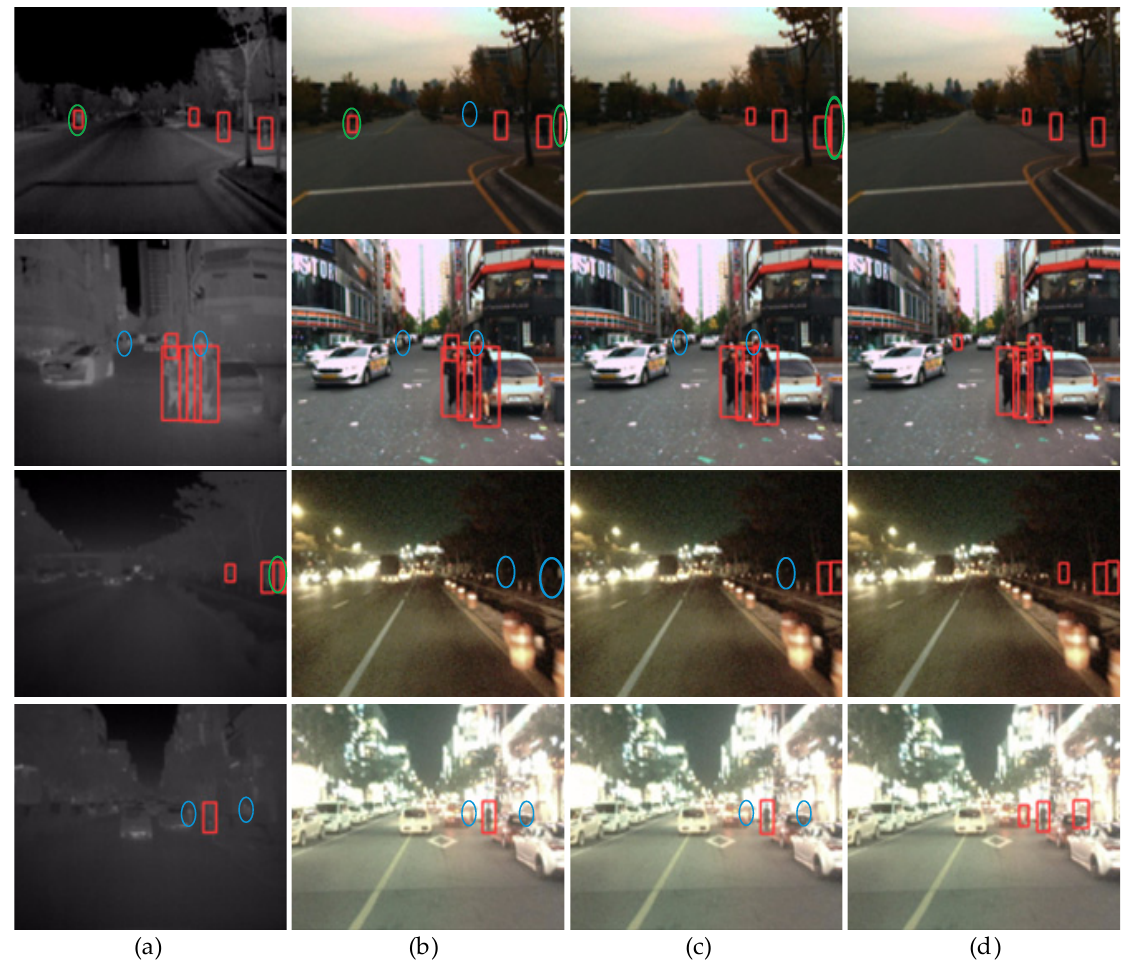
Figure 10. Visualization of only infrared images ( a ), only visible images ( b ), addition method ( c ), and proposed LAIIFusion ( d ) detection results on KAIST dataset. The missed object is marked with blue circles. The incorrect object is marked with green circles. Red rectangles represent the detected pedestrian target.